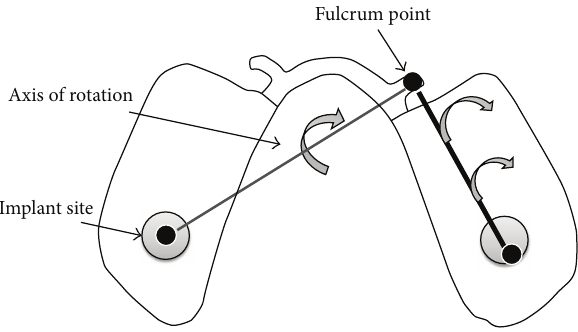
Figure 10: Twisting of the prosthesis around the axis of rotation during unilateral loading of right